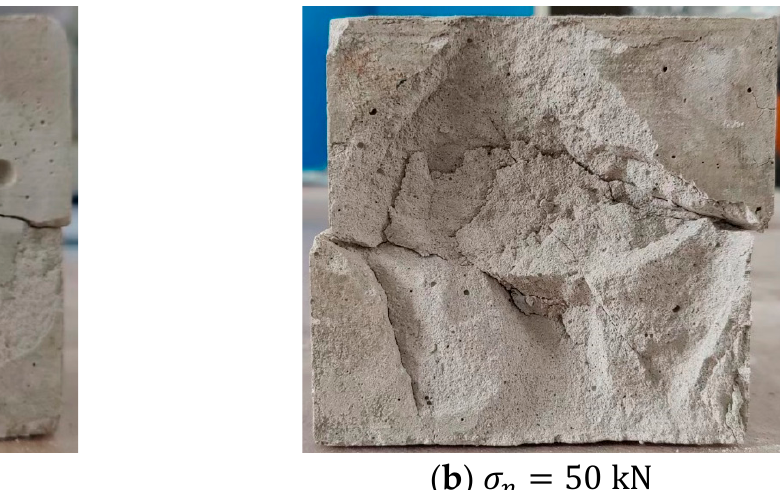
Figure 4. ( a ) Failure shape of specimen under 30 kN normal load. ( b ) Failure mode of specimen under 50 kN normal load.